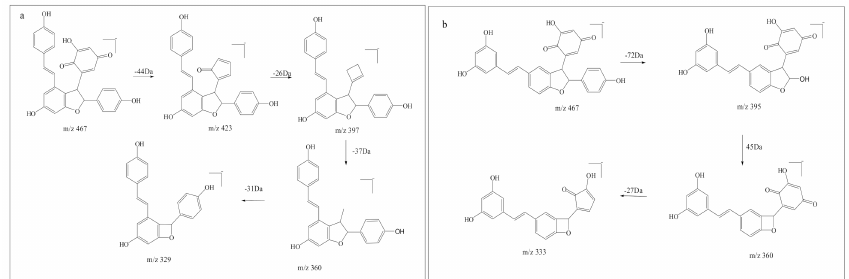
Figure 5. The fragmentation pathway of the two resveratrol dimer oxidations. ( a ) trans- ε -viniferin + 1 O δ -viniferin + 1 O 2 ; ( b ) trans- 2